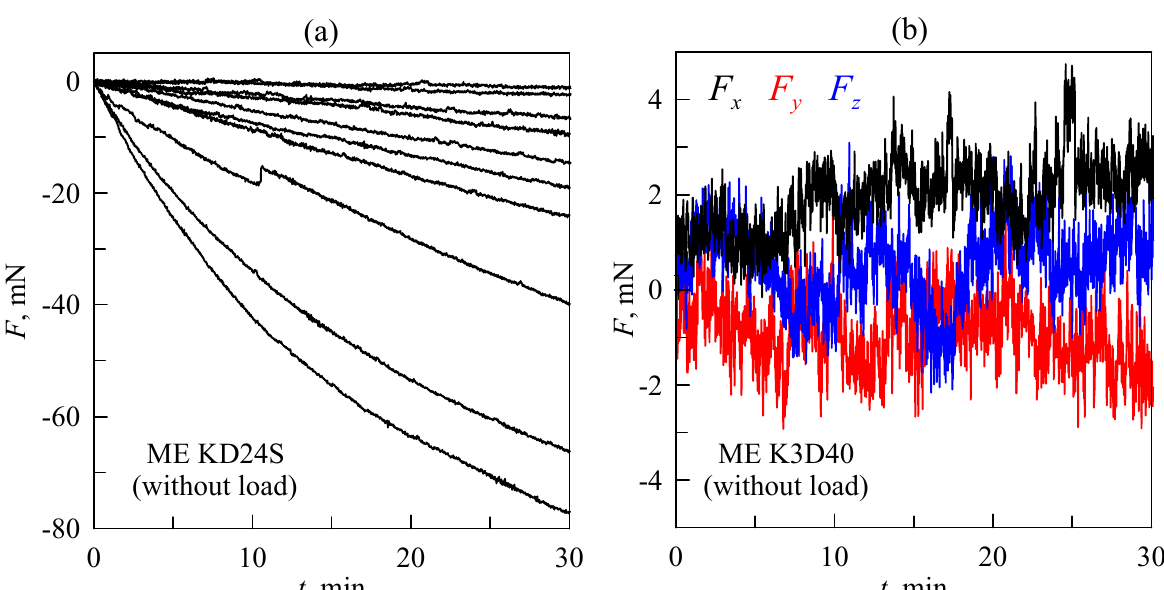
Figure 5. Time dependencies of “force” measured by an unloaded sensor (signal drift). ( a ) Ten dependencies corresponding to different measurements obtained by the ME KD24S sensor. ( b ) Time dependencies of three components of a force measured by the ME K3D40 three-axis sensor in one experiment.